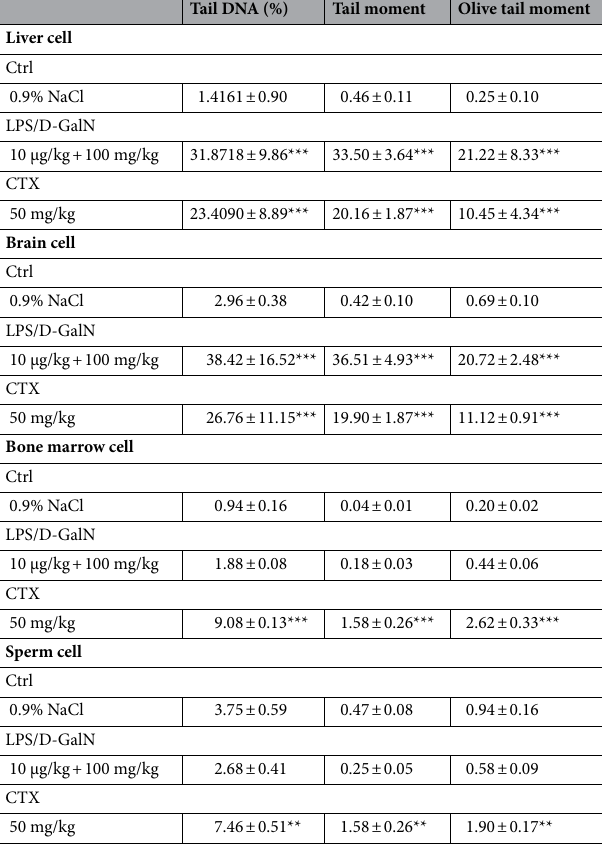
Table 2. DNA damage in cells from the liver, brain, bone marrow and testes (sperms) extracted from mice chronic administered with LPS/D-GalN. Mice were peritoneally injected with LPS/D-GalN (10 μg/ kg + 100 mg/kg body weight) every other day for 8 weeks. Saline solution (0.9%) and cyclophosphamide (CTX) (50 mg/kg body weight) given in the same mode as described above were used as negative and positive control, respectively. SCGE assay was performed using cells from each tissue. Data are expressed as means ± S.D.; * P < 0.05, ** P < 0.01 and *** P < 0.001, compared with the control